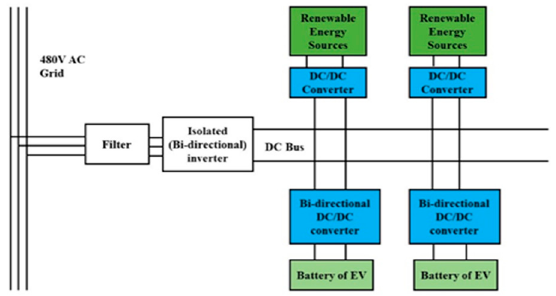
Figure 10. Power architecture of AC EVCS.